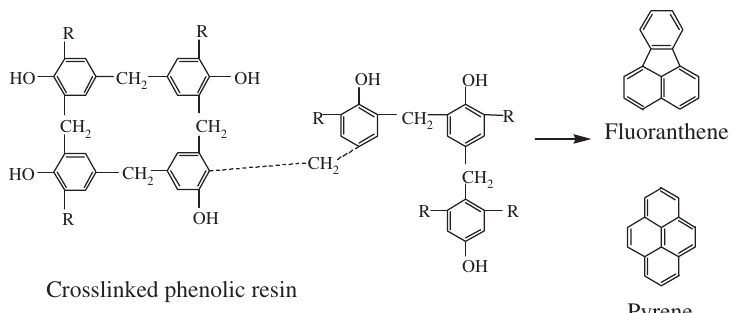
Figure 5 The phenolic resin pyrolysis schematic diagram in inert gas.